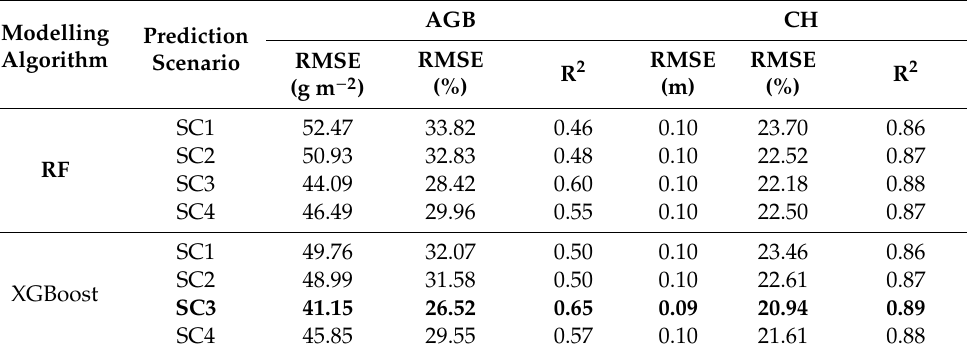
Table 5. Pasture aboveground biomass (AGB) and canopy height (CH) estimates based on the spectral bands (SC1), the vegetation indices (SC2), the optimum texture measures (SC3), and the combination of spectral bands, vegetation indices, and the optimum texture measures (SC4) using the random forest (RF) and extreme gradient boosting (XGBoost) regression algorithms. The best performing models are highlighted in boldface.